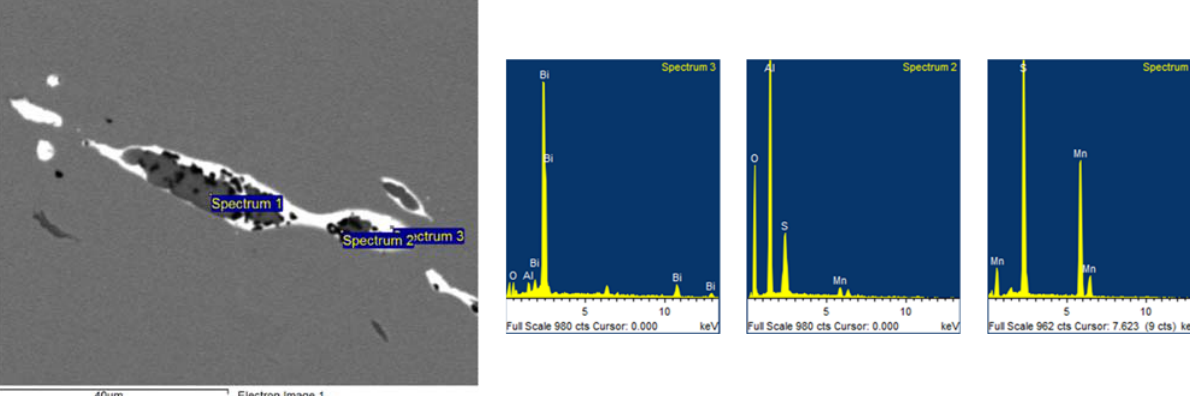
Figure 12. EDX spectra of complex particles in CMnCr steel with 0.12 wt. % Bi.